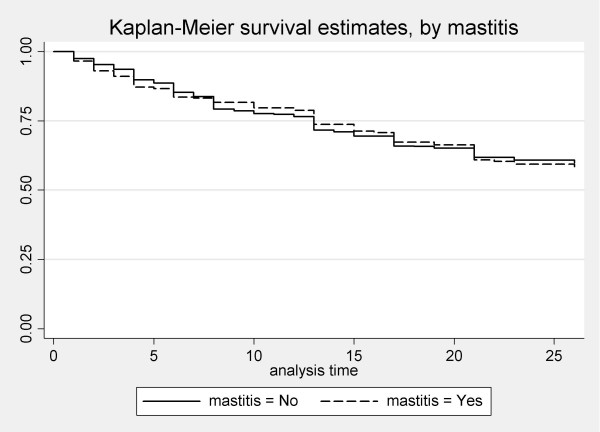
Duration of breastfeeding, by mastitis.